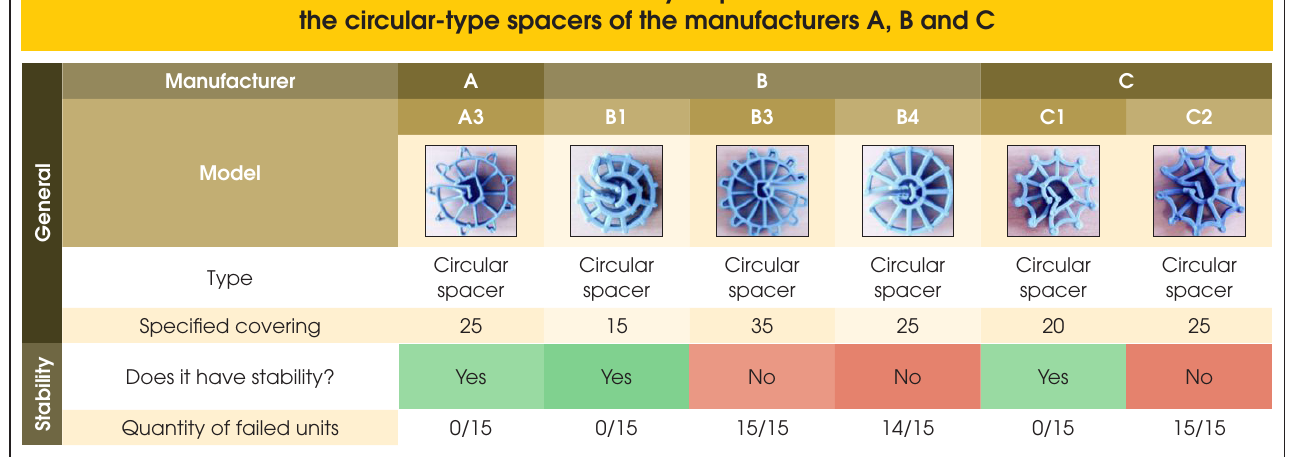
Table 15 – Results of the stability requirement evaluation